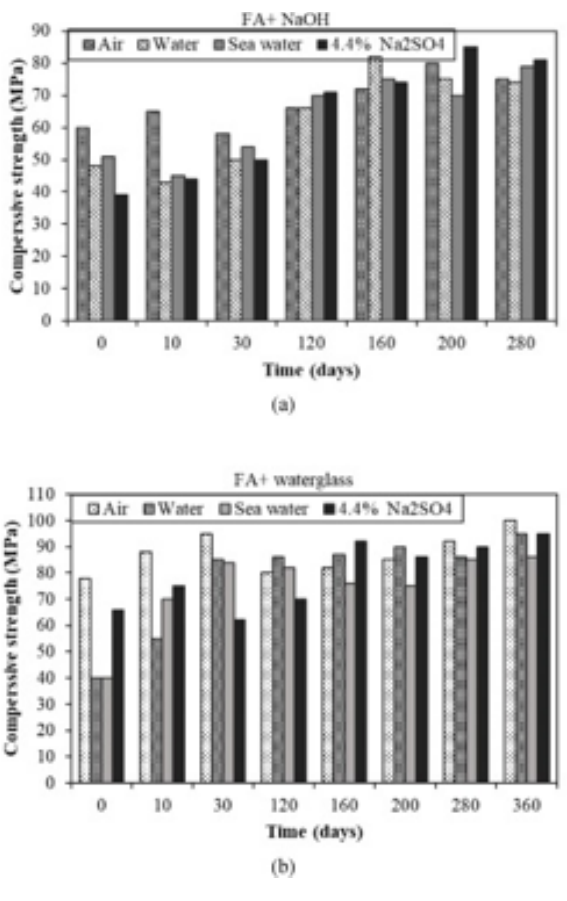
Figure 12: Mechanical strength of fly ash mortars (a) NaOH- activated, and (b) water glass-activated [71]